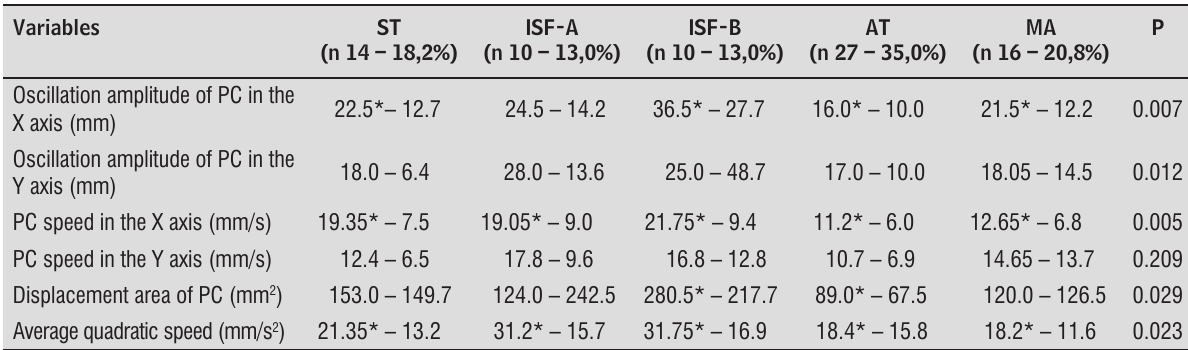
Table 2 – Stabilographic parameters of platform presented as mean and standard deviation according to the physical activi- ty practice